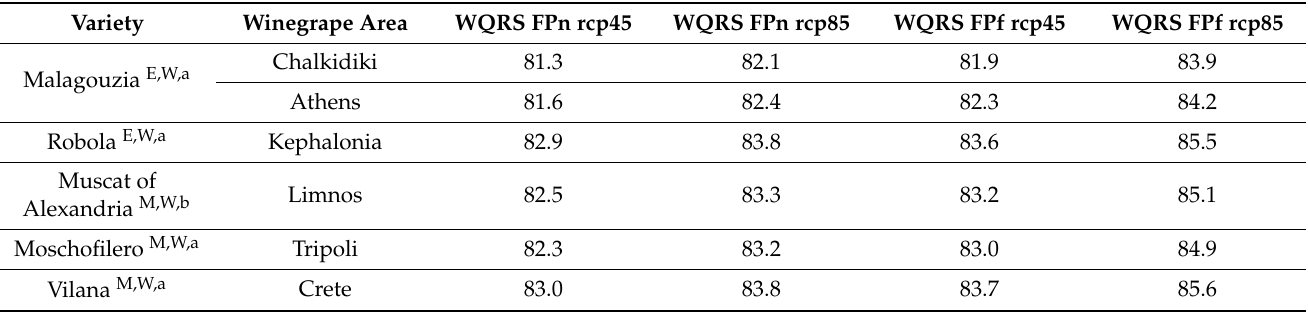
Table 6. Future wine quality rating statistics for the 11 principal winegrape varieties (10 indigenous and 1 international) cultivated in 13 principal winegrape regions in Greece. Varieties and regions are presented in the first two columns. Average wine quality rating scores for FPn and FPf un- der RCP45 and RCP85 are given in columns 3–6. Each variety has superscript letters indicating indigenous (a) and international varieties (b); early (E), mid (M) and late (L) season varieties; and red (R), white (W)